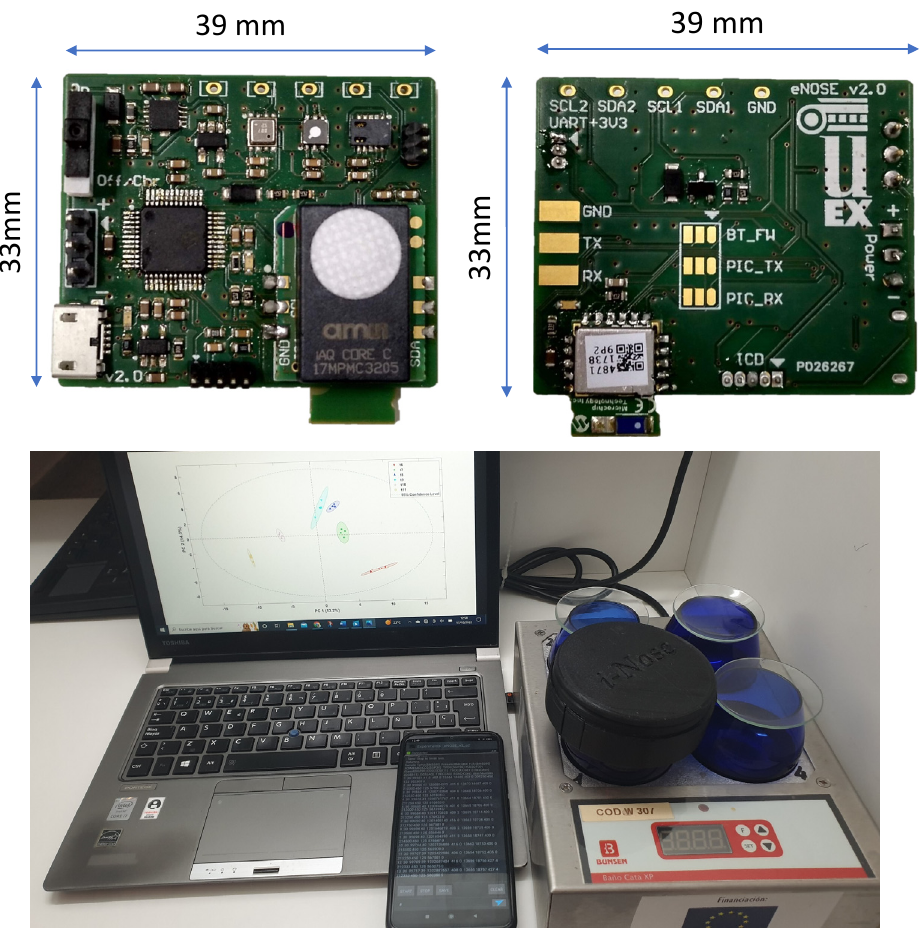
Figure 1. E-nose electronic board (view from front and above) and the different components involved in the measurements.